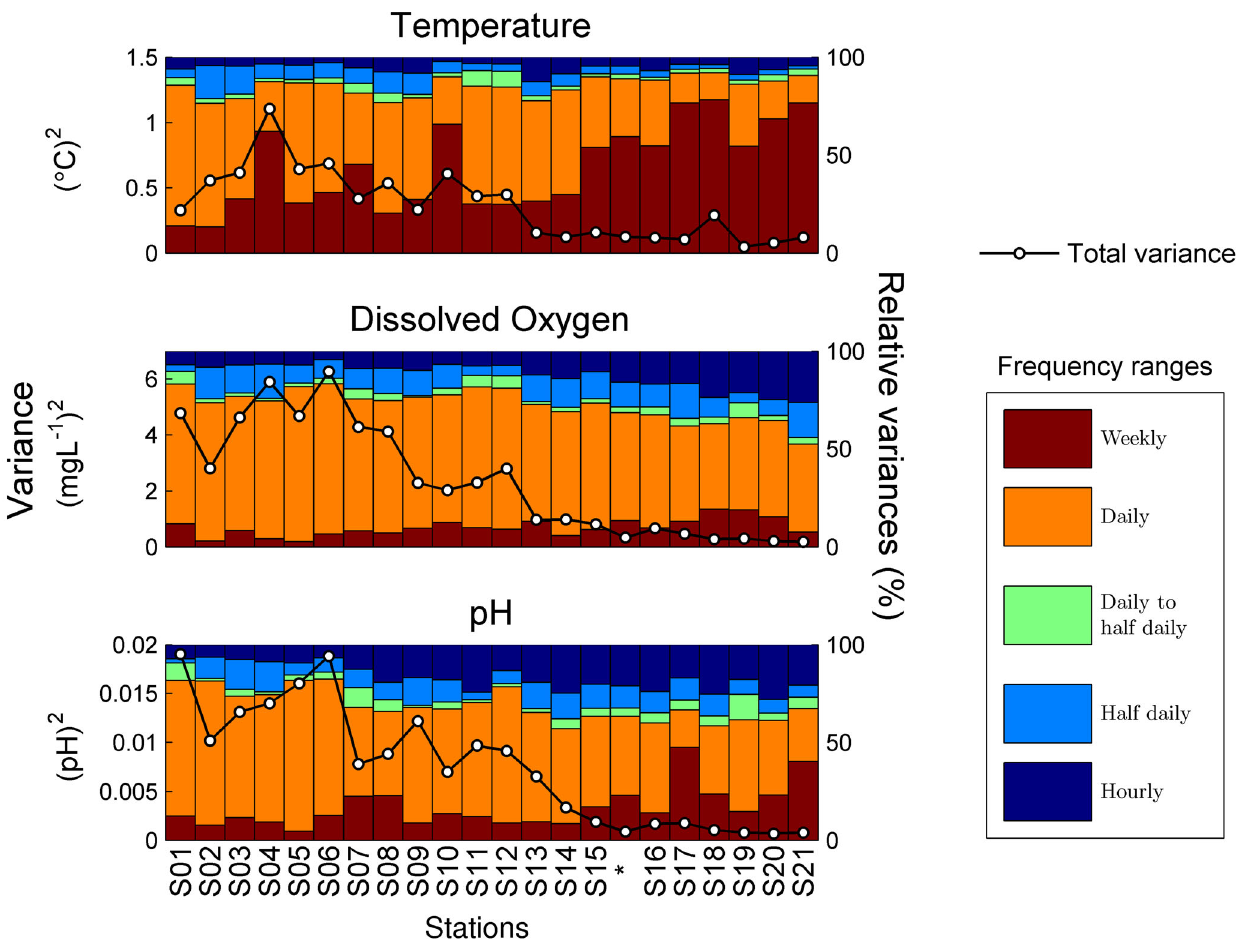
Figure 5. Variance decomposition along the transect. Variance decomposition of temperature, dissolved O 2 concentration and pH for each one of the deployments along the inshore/offshore transect. Left axes scale absolute variances (black lines), and right axes the relative contribution (in %) of each frequency range to total variance. Sites are ordered from shallowest and closest to shore (S1) to deepest and most offshore (S21). The asterisk marks the average values from the long-term water column station, positioned within the transect according to its